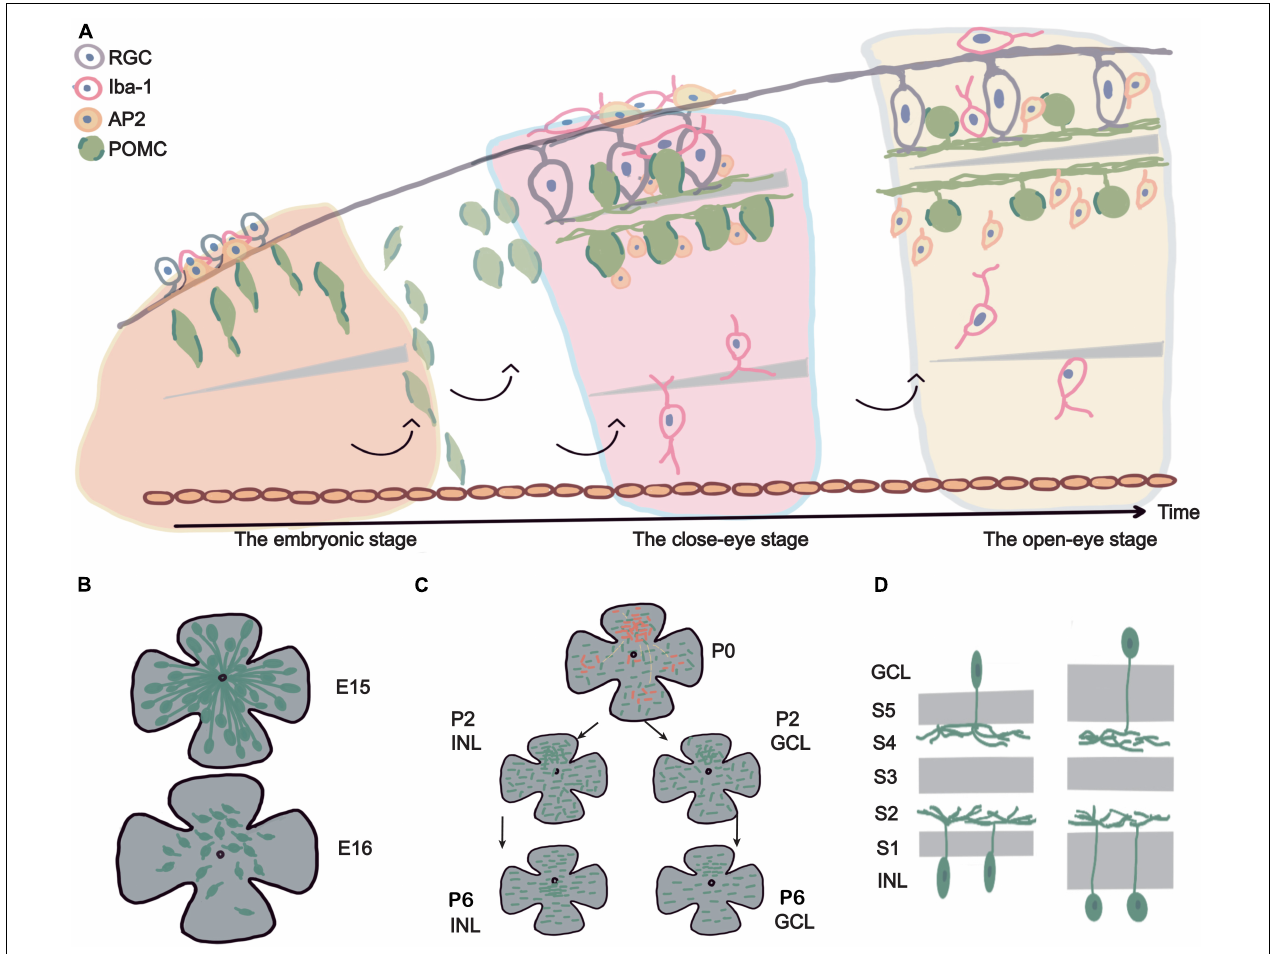
FIGURE 8 | Summary schematic diagram. (A) The life span of POMC ACs and related retinal cell development. The figure shows the development of POMC ACs from an embryo to the adult stage (from left to right). The upside is the basal side (RGCs side), and the downside is the apical side (retina pigment cell side). POMC ACs first showed long axons on the basal side, fusiform soma, and had a high density. Then POMC ACs were divided into two layers and formed the inner plexiform layer (IPL). The IPL became wide, two layers of cells increased in number, and the soma became ellipsoidal at P2 to P6. RGCs also developed dendrites to form the IPL. Microglial cells gradually migrated to the OPL. At late developmental stages, POMC ACs had round soma and a stable GCL/INL ratio of about 0.5. (B) E15–E16 cliff descent. From E15 to E16, the retina size increased 1.5 times, while the cell density decreased more than 10 times. Cells lost their long axons, and dendrites began to develop. (C) Discontinuous development, superior asymmetry, and regularity increased. Considering P2 as an example, the dense pole was in the superior retina, and cells were more developed (shown with red points). These cells were also located in other areas and were separated by less developed cells (black points). The cell mosaic was irregular (with short lines at different directions). At P6, the INL dense pole moved to the optic disc, whereas the GCL dense pole was still in the superior retina. The mosaic regularity reached a peak, with increased cell density. (D) Sublamina development. The IPL had five sublamellas; from inner to outer, they are named S1 to S5. The POMC AC dendrites are located in the S2 and S4 lamellas. At later developmental stages, the S2–S4 sublamellas maintained the same width, whereas S1 and S5 widened, and the soma became